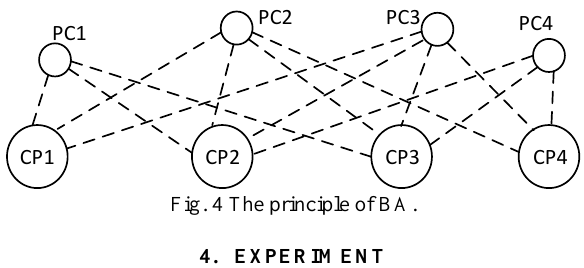
Fig. 5 The change in matching points and matching accuracy with the increasing of variance. (a) The result of Fig. 6(a). (b) The result of Fig.